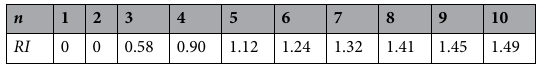
Table 7. Random consistency index 74